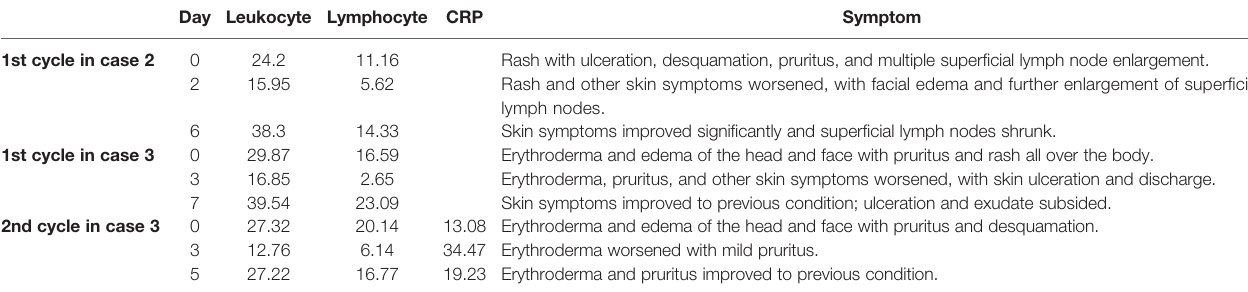
TABLE 1 | Changes in leukocytes, lymphocytes, CRP concentrations, and skin symptoms three fl are reactions. Day Leukocyte Lymphocyte